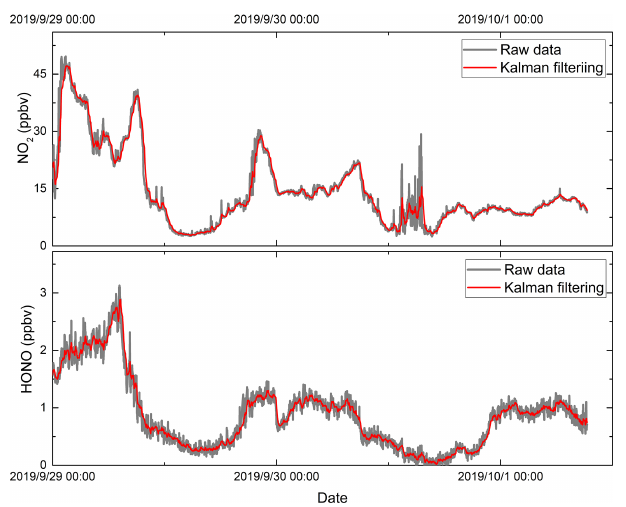
Figure 13. The measurement results for HONO and NO 2 with and without Kalman filtering under ambient conditions. The red line is the concentration result after processing with Kalman filtering tech- nology, and the grey line is the result for original concentration